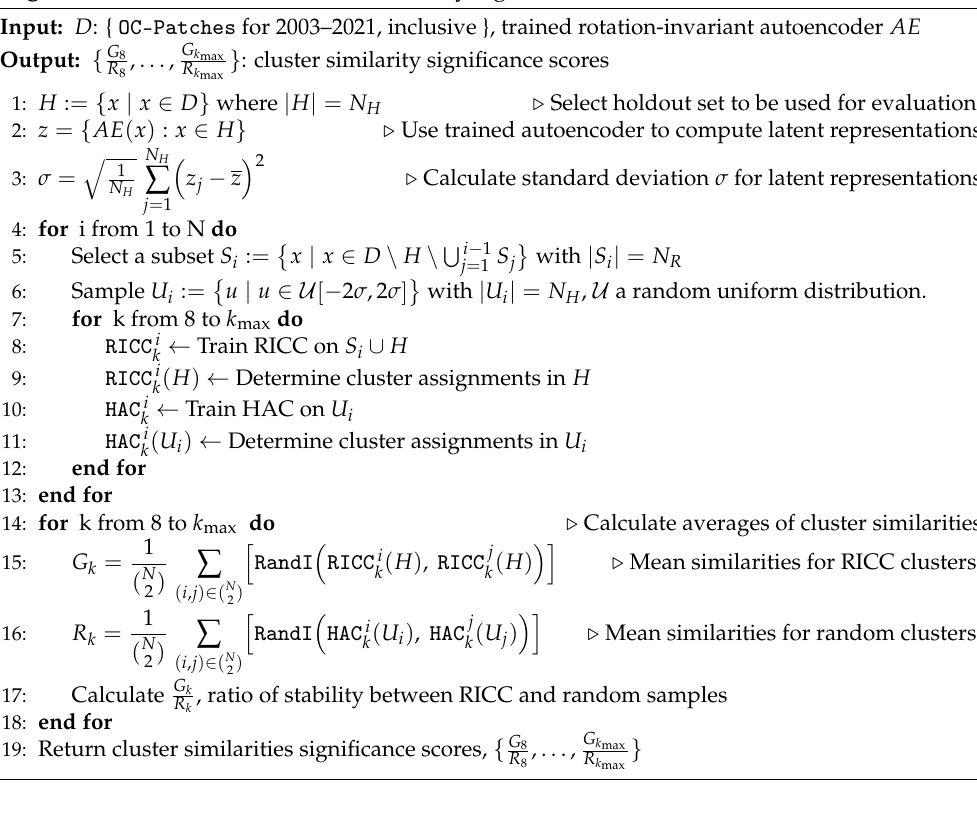
Algorithm A2 Pseudocode for the stability significance test described in Section